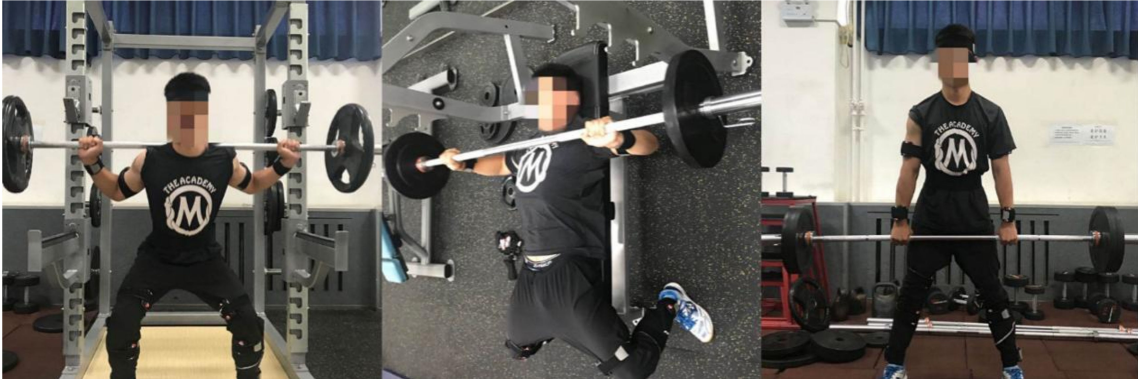
Figure 3. Subject information collection